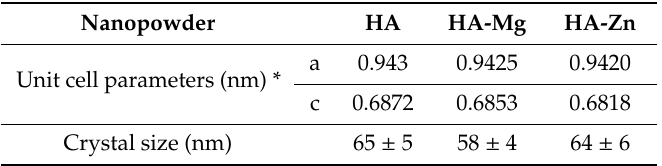
Table 1. Parameters obtained from the PXRD patterns: unit cell parameters a and c (nm) and average crystallite sizes determined from (002)